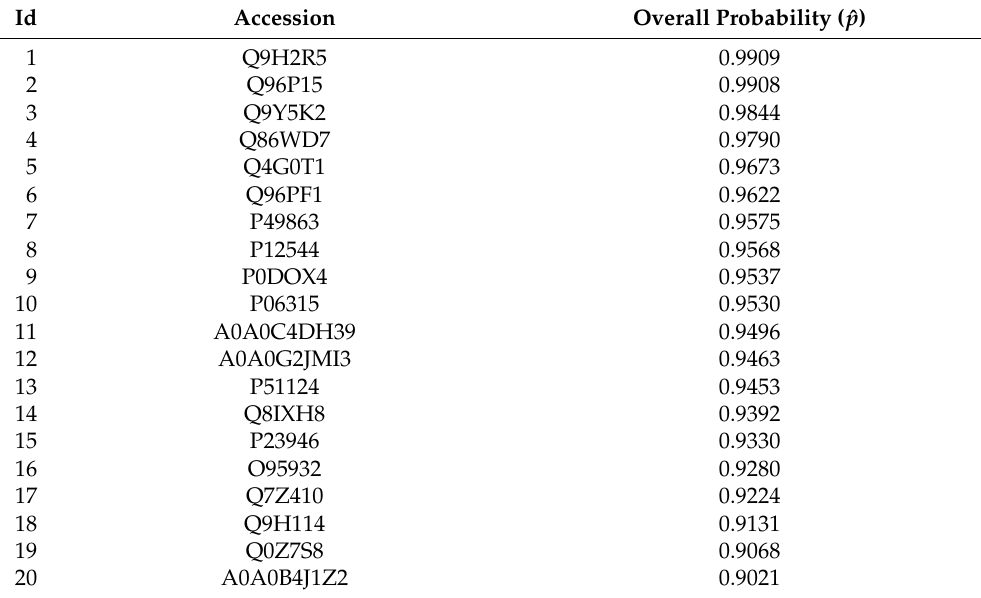
Table 6. Potentially universal secreted proteins in 17 human body fluids with an overall probability greater than